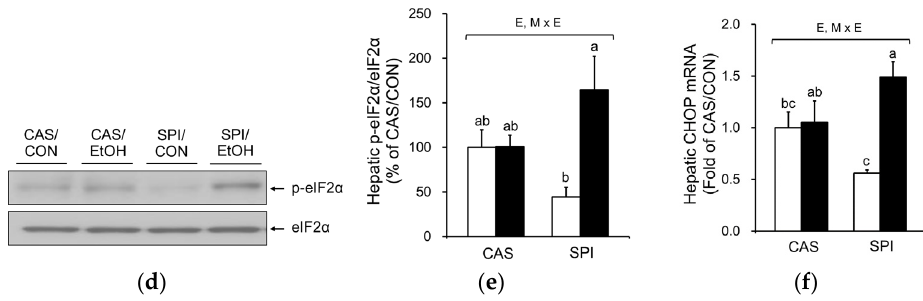
Figure 4. Effects of maternal diet on the endoplasmic reticulum (ER) stress response in adult offspring fed an ethanol diet. ( a , b ) Hepatic spliced:unspliced XBP1 mRNA levels were analyzed by semi ‐ quantitative PCR and normalized to ACTB as an endogenous control ( n = 4–5). (c) Correlation between hepatic spliced:unspliced XBP1 mRNA levels and serum GPT levels. ( d , e ) Hepatic p ‐ eIF2 α protein levels were analyzed by immunoblotting and normalized to total eIF2 α protein levels. ( f ) Hepatic CCAAT/enhancer binding protein homologous protein (CHOP) mRNA levels were analyzed by real ‐ time PCR and normalized to ACTB as an endogenous control ( n = 5). Data are expressed as means ± SEM. Significant effects of maternal diet (M), offspring ethanol diet (E), and their interaction (M × E) were analyzed by two ‐ way ANOVA ( p < 0.05). Means without a common superscript significantly differ based on post ‐ hoc analysis ( p < 0.05). Pearson correlation coefficient, r , and p ‐ value are indicated. Data that were not normally distributed were log ‐ transformed before the statistical analysis. CAS, casein; SPI, low ‐ isoflavone soy protein isolate; CON, control; EtOH, ethanol.